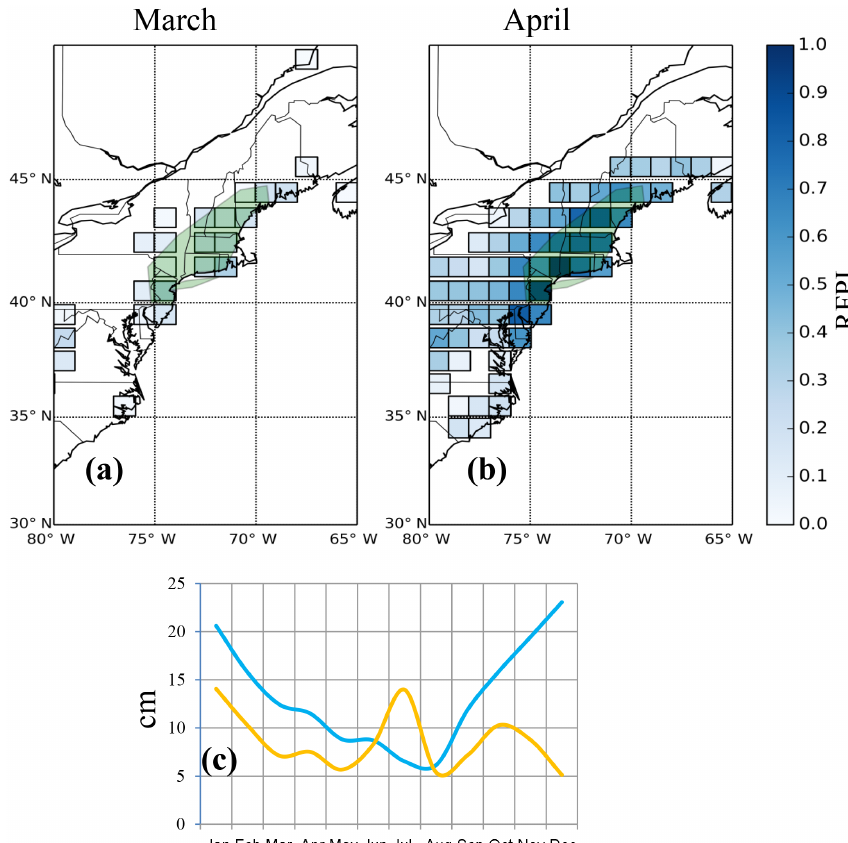
Figure 8. The 2007 flood in the northeastern USA. (a) grid cells with positive RFPI values in March, 1 month before the flooding; (b) grid cells with positive RFPI values in April, the flooding month; (c) the average storage deficit (blue line) and precipitation (yellow line) over the northeastern USA from October 2006 to September 2007. In (a) and (b) , the DFO-reported flood area is shown as green